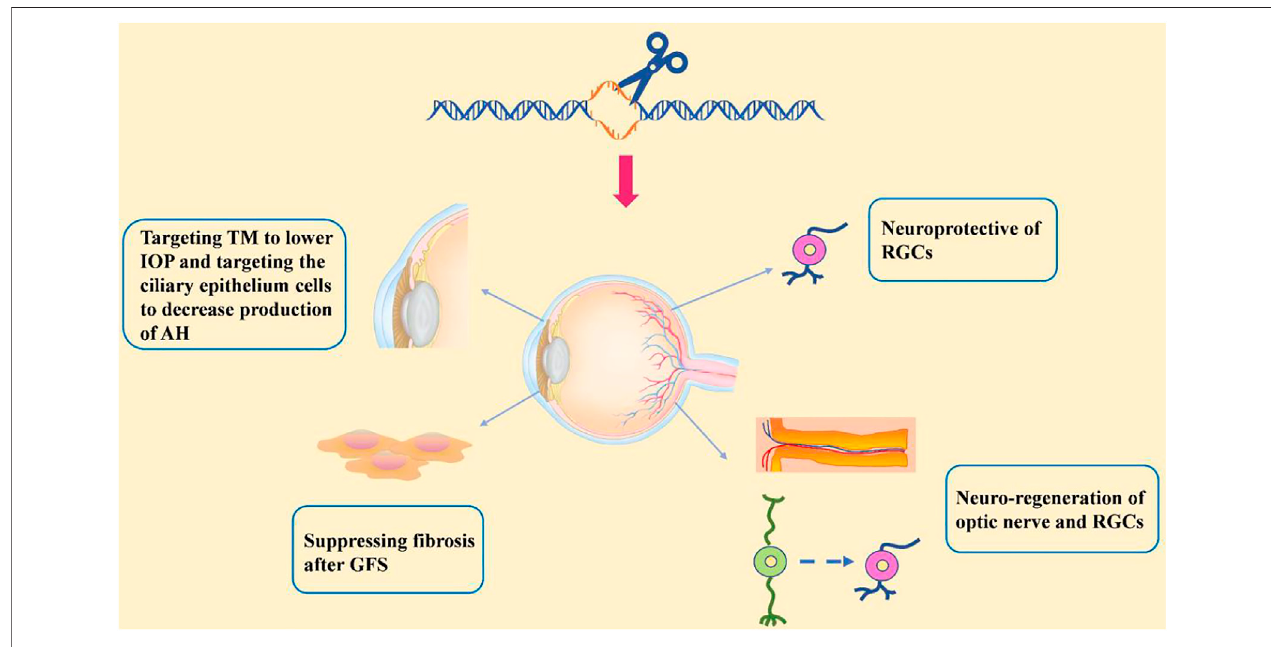
FIGURE 4 | An overview illustration of the